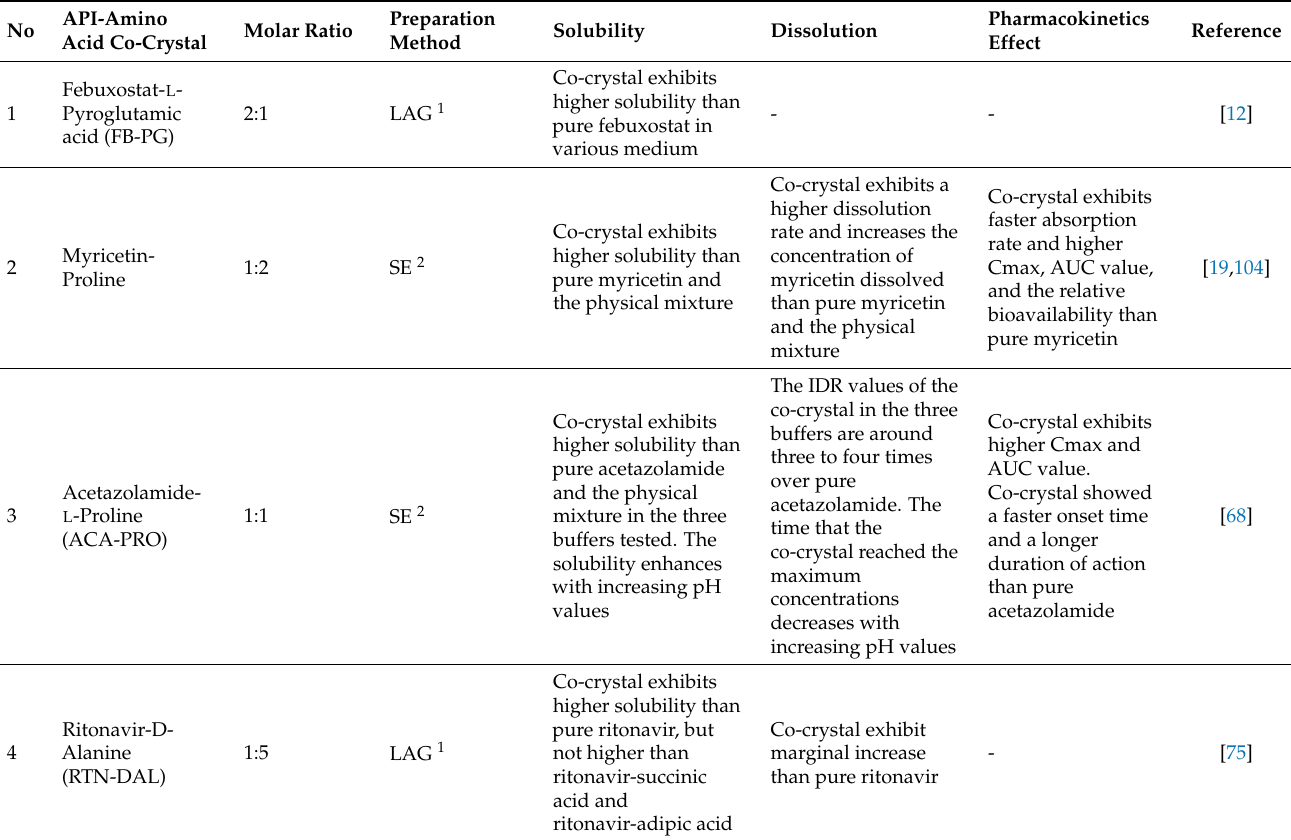
Table 2. Summary of a few reports on API-amino acid co-crystals and the pharmaceutical